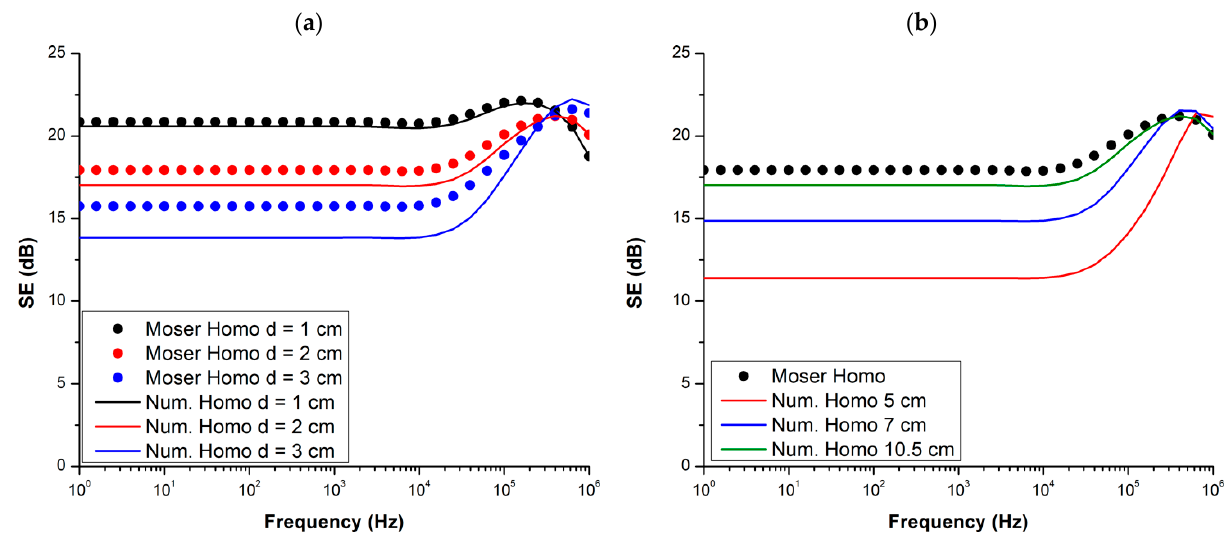
Figure 7. Shielding effectiveness of the homogenized layer obtained with Moser model (dot) and numerically (line) in near-field for different distances d with a sample radius of 10.5 cm ( a ), and for different sample radius with a distance d of 2 cm ( b ).